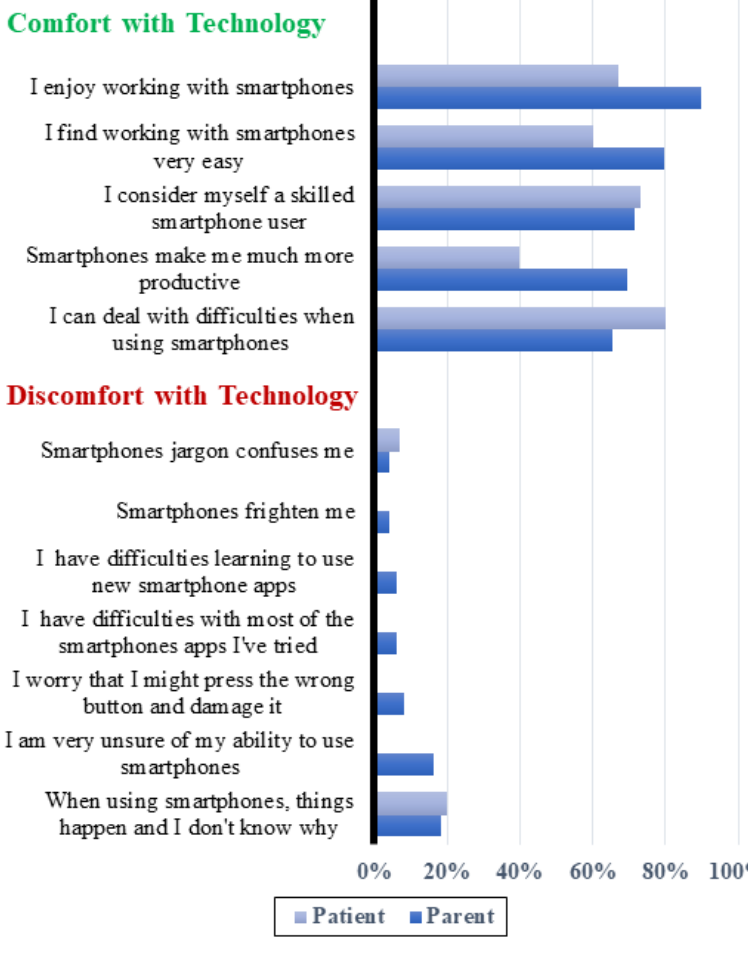
Figure 2. Parents’and patients’comfort and discomfort with